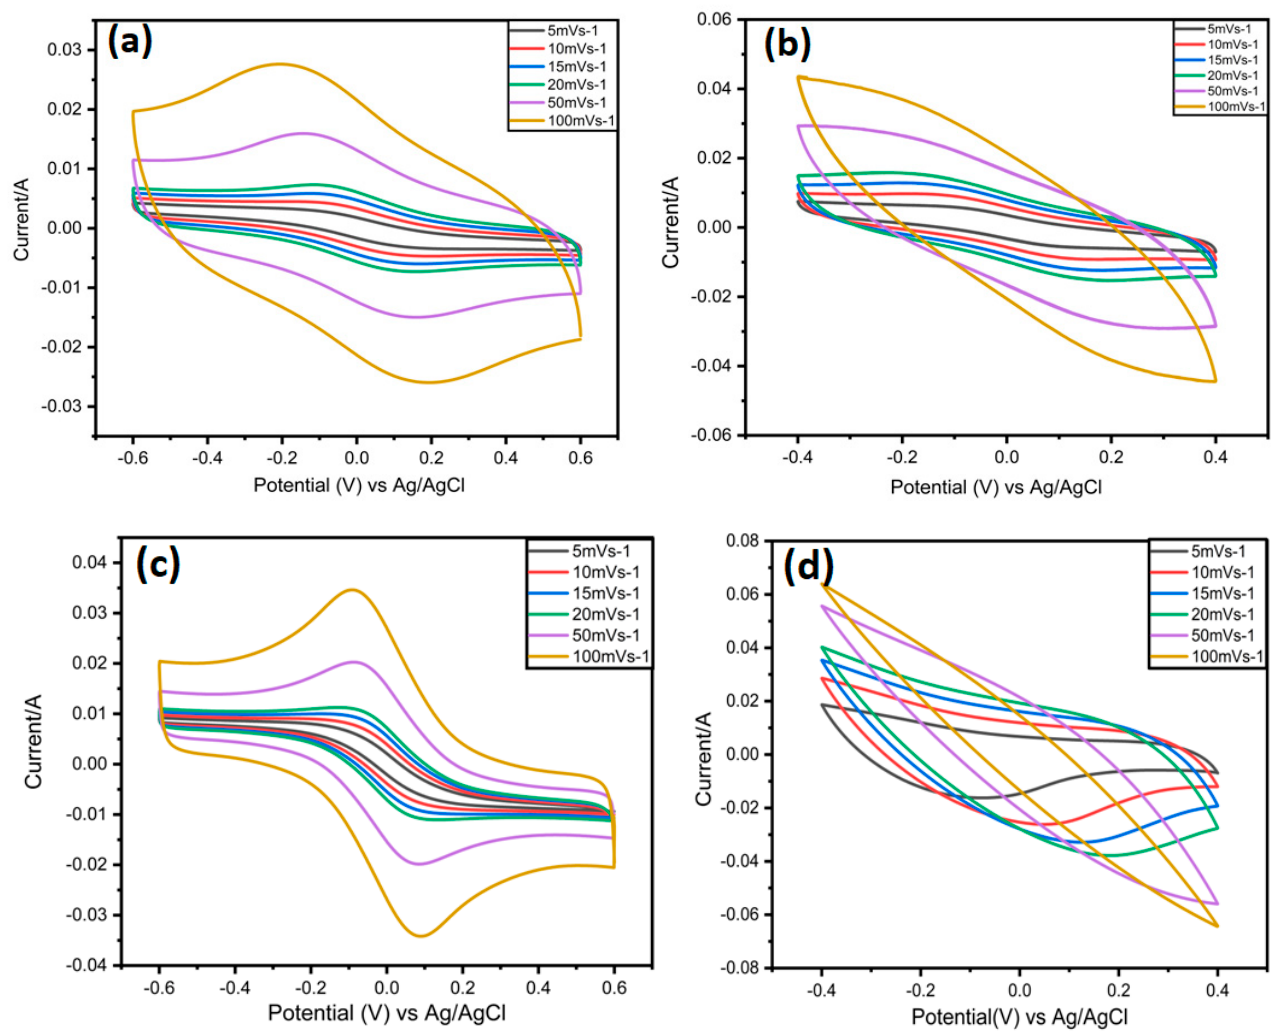
Figure 7. ( a ) CV curves of Symmetric SC of MXene at different scan rates 1 M H 2 SO 4 ; ( b ) CV curves of Symmetric SC of MX/AuNPs at different scan rates in 1 M H 2 SO 4 ; ( c ) CV curves of Symmetric SC of MX/AuNPs at different scan rates in 3 M H 2 SO 4 ; ( d ) CV curves of MX/Au electrode in 3 M H 2 SO 4 .